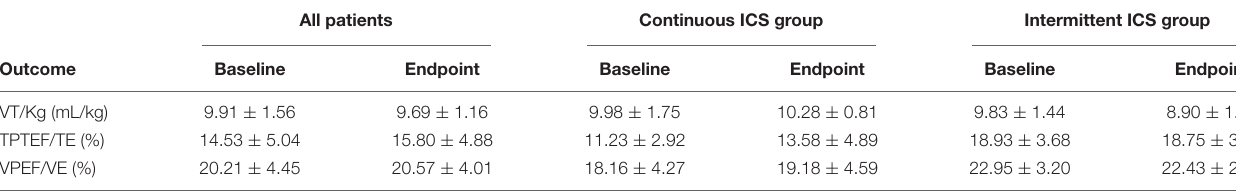
TABLE 4 | Lung function before and after 1 year in patients with PIBO (age ≤ 5 years). All